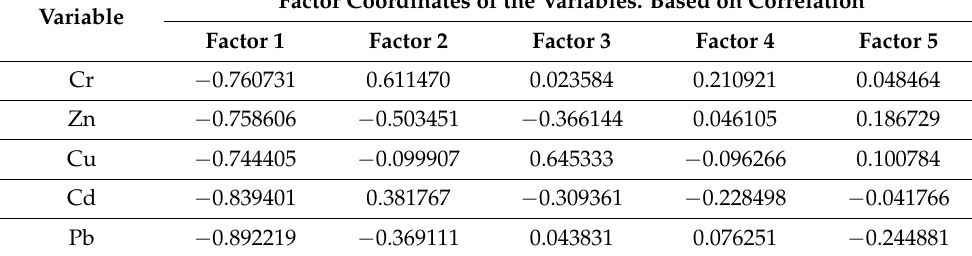
Table 3. The results of the Principal Components Analysis. Factor Coordinates of the Variables. Based on Correlation Variable Factor 1 Factor 2 Factor